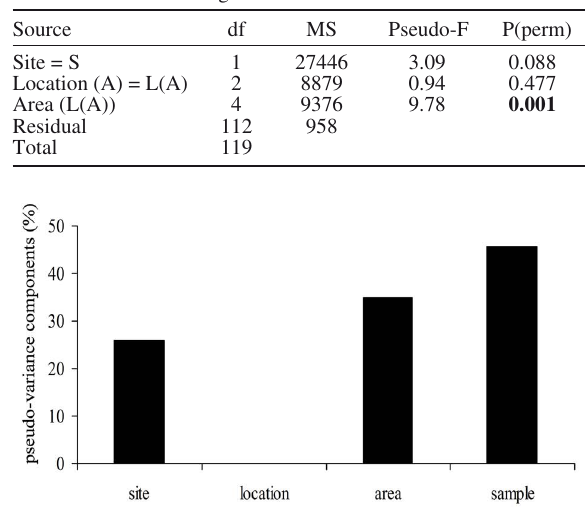
Table 2. – Results of PERMANOVA analysis comparing the mor- 5. – Results of PERMANOVA analysis on morphological phological groups composition and abundance datasets obtained groups composition and abundance of coralligenous assemblages through the photographic method and using different sampling obtained with the photographic method applied at different spatial areas (400 cm 2 and 1875 cm 2 ). scales. Significant effects are in bold.